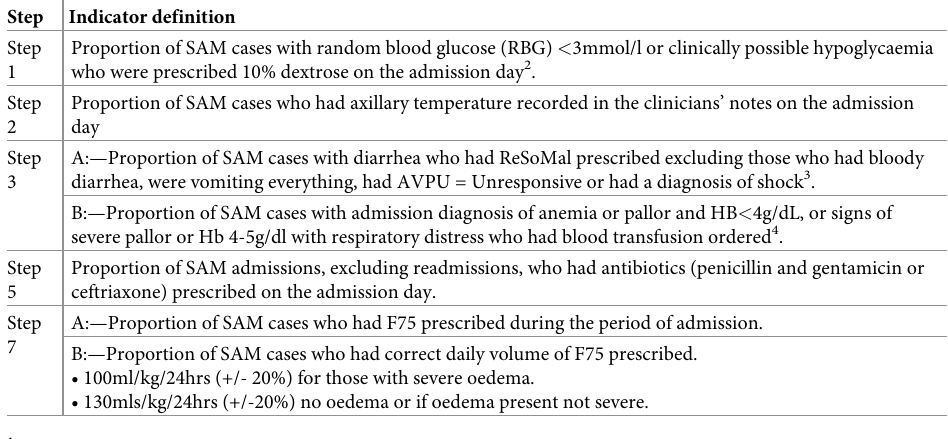
Table 1. Definition of quality of care indicators used to assess performance of clinicians in SAM management 1